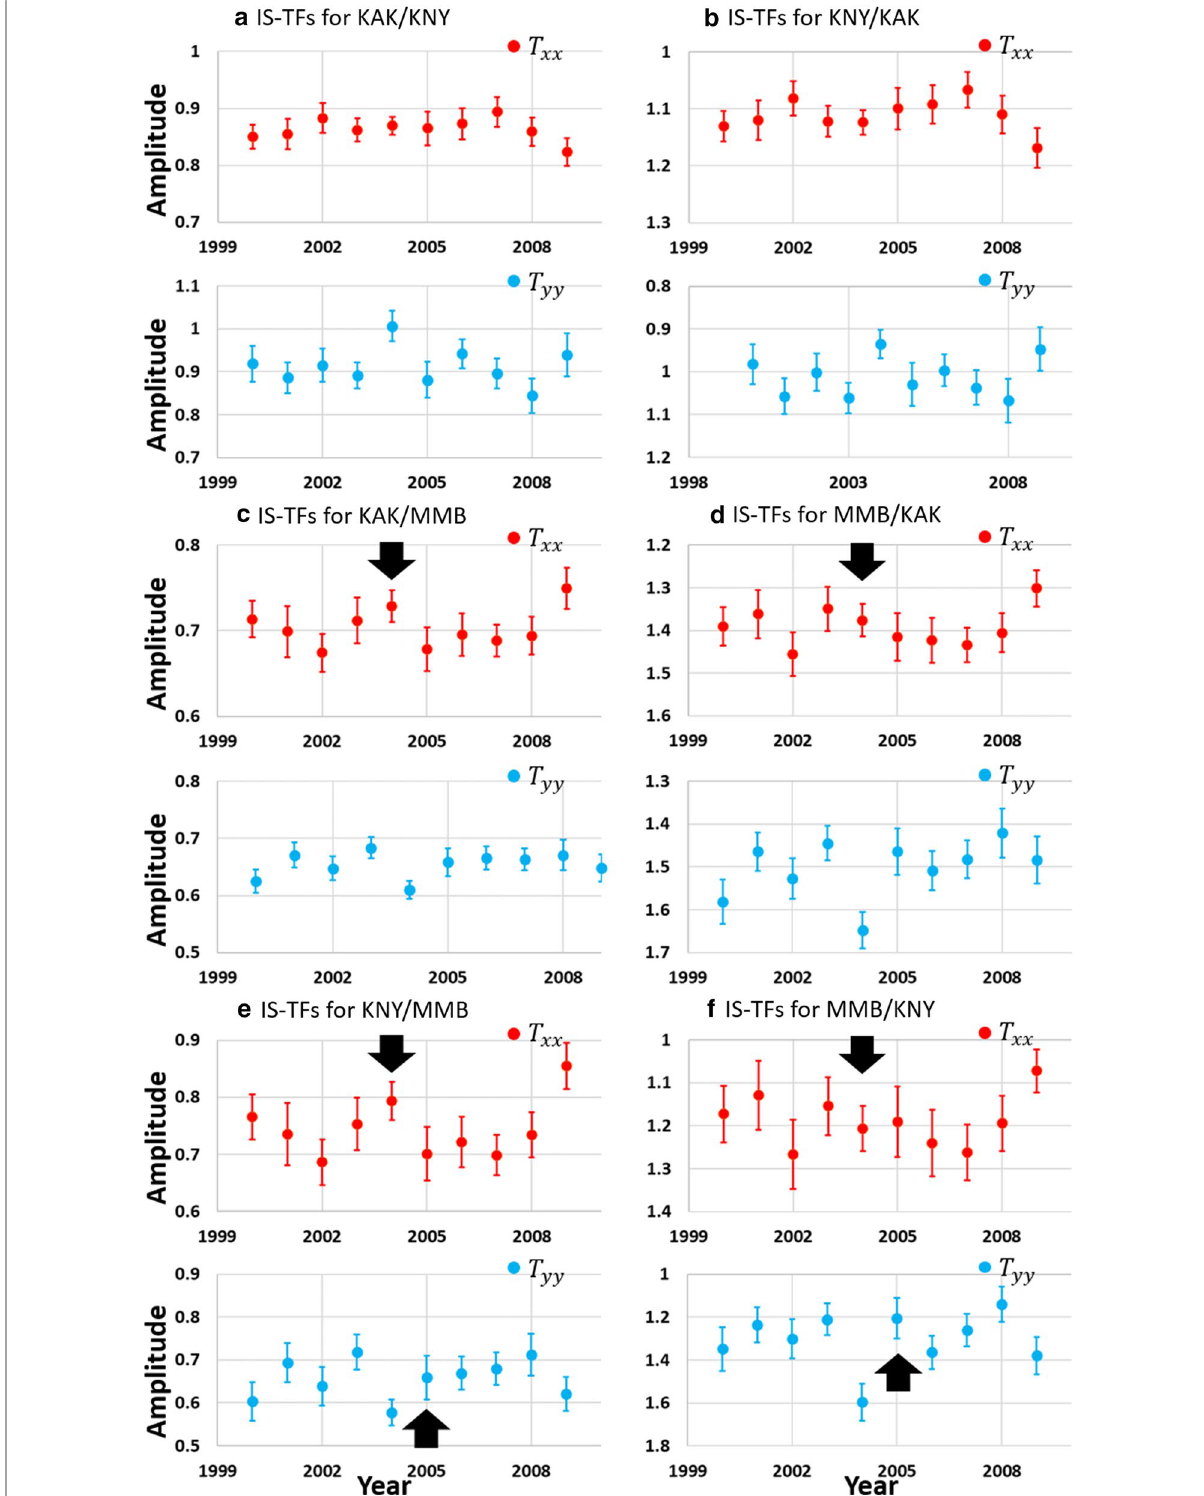
Fig. 7 IS‑TFs at 9/30,720 Hz derived from the data during October/November from 2000 to 2009. a IS‑TFs for KAK/KNY. The vertical axis denotes the absolute amplitude of IS‑TFs and the horizontal axis denotes years. b KNY/KAK. c KAK/MMB. d MMB/KAK. e KNY/MMB. f MMB/KNY. The red points denote T xx and the light‑blue points denote T yy . Note that the vertical axes of b , d , and f are reversed. Error bars correspond to 95% confidence